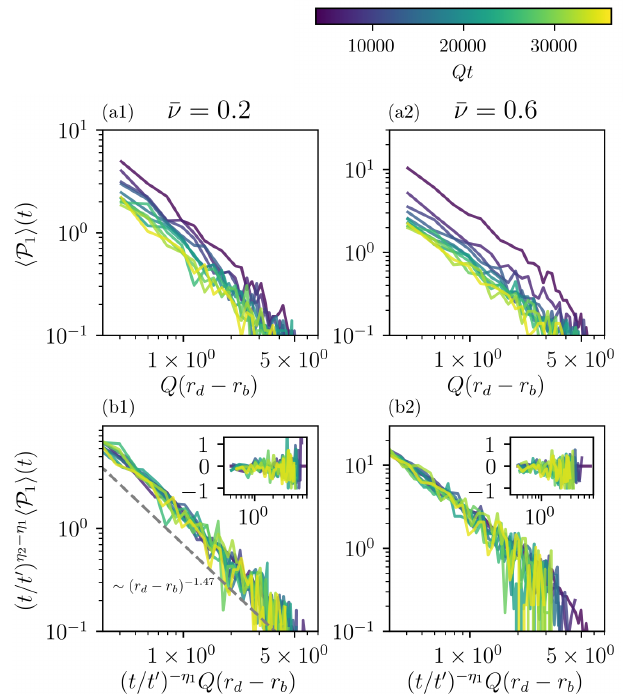
Figure 13: Persistence distributions. Each column shows data for the indicated fil- tration parameter, ¯ ν . The employed time-dependent scaling exponents are displayed in Fig. 8. Insets show corresponding